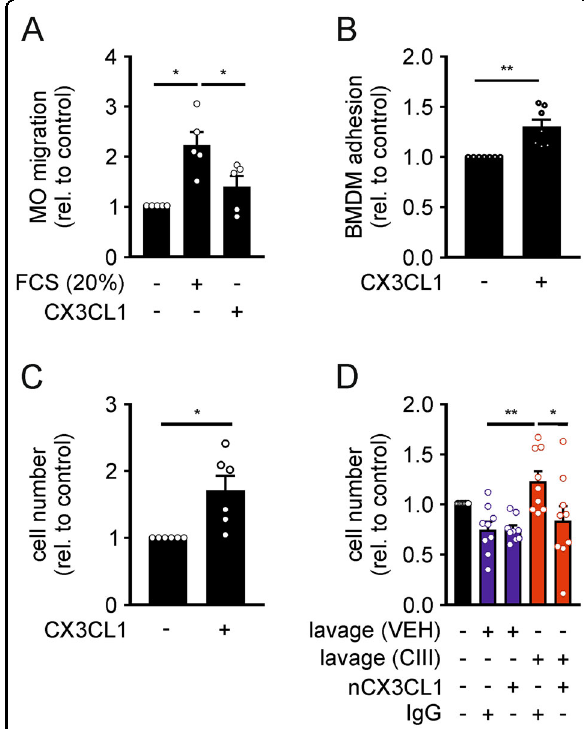
Fig. 4 CX3CL1 enhances adhesion and survival of myeloid cells. A Murine blood monocytes (MO) were allowed to migrate towards CX3CL1 (100 ng/mL), or medium containing 20% FCS in a Boyden chamber assay for 4 h. The number of MO migrated to the lower compartment was determined by FACS. B Bone marrow-derived macrophages (BMDM) were allowed to adhere to fi bronectin-coated surfaces in the presence or absence of recombinant CX3CL1 (100 ng/ mL). Adhesion was determined after 1 h. C , D BMDM were grown for 48 h in medium supplemented with C recombinant CX3CL1 (100 ng/ mL) or D peritoneal lavage fl uid (1:2) from vehicle control (VEH)- or